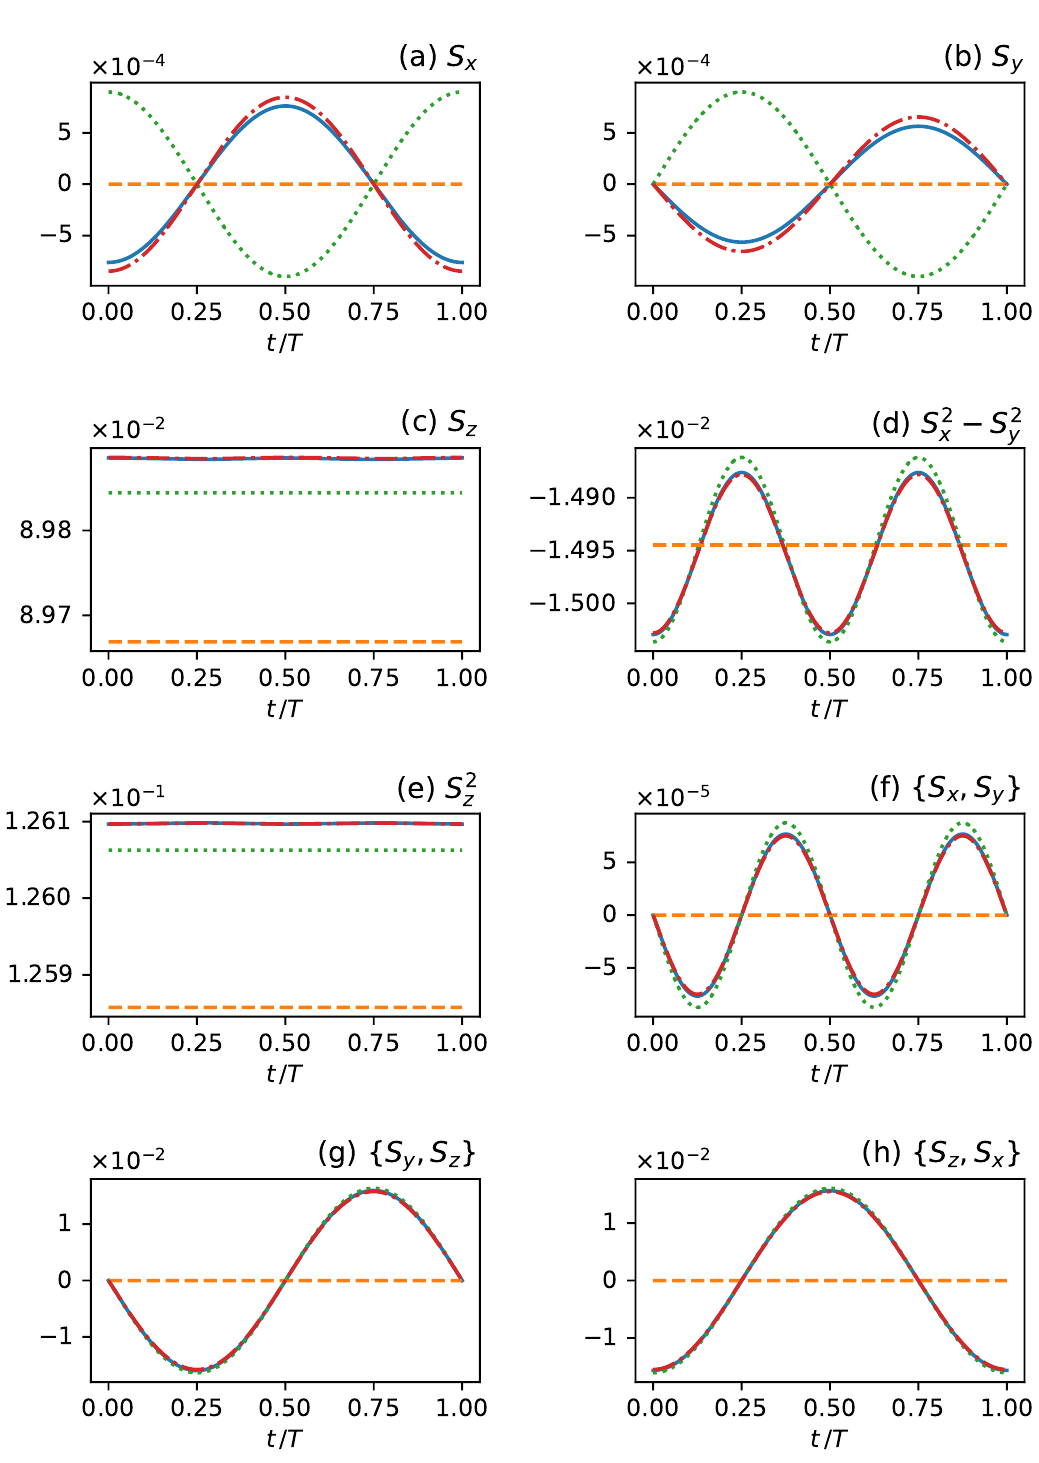
Figure 7: NESS in one cycle calculated by the exact numerical integration (blue) and by the HF expansion approach at order N = 0 (orange), 1 (green), and 2 (red). All the independent 8 observables are plotted in each panel. For each N , we expand = (cid:98) ( N + 1 ) / 2 (cid:99) . The parameters are chosen as H and K ( t ) up to O ( ω − N ) and set k c eff = 0.3, N = 1, N = 0.05, B = 0.1, ω = 10, β = 3, γ = 0.2, and Λ = B s z x y d 0